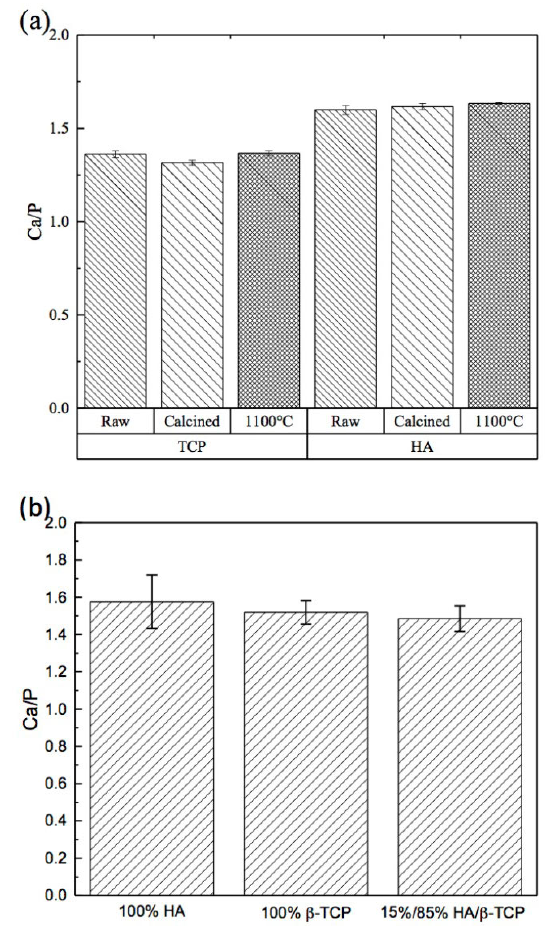
Fig. 2 (a) Mean ± 95% confidence intervals for Ca/P ratio depicting the two primary groups (HA and β-TCP) and their state. (b) Mean ± 95% confidence intervals for Ca/P ratio of the experimental